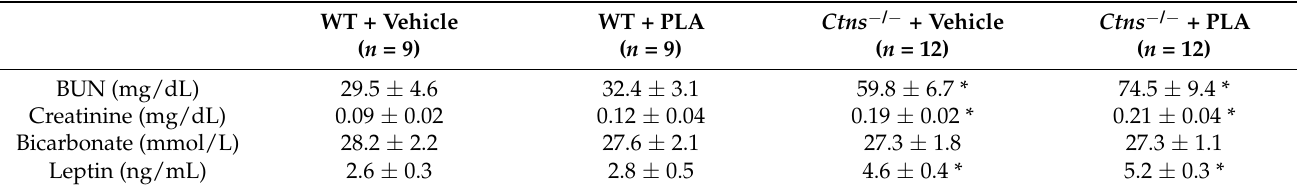
Table 1. Serum and blood chemistry of mice. Twelve-month-old Ctns − / − and WT mice were treated with PLA (7 mg/kg/day, IP) or vehicle (normal saline) for 28 days. Four groups of mice were included: WT + Vehicle, WT + PLA, Ctns − / − + Vehicle and Ctns − / − + PLA. Ctns − / − + Vehicle mice were fed ad libitum whereas WT + Vehicle, WT + PLA and Ctns − / − + PLA mice were pair-fed to that of Ctns − / − + Vehicle mice. Data are expressed as mean ± SEM. Results of Ctns − / − + Vehicle mice were compared to those of WT + Vehicle mice whereas results of Ctns − / − + PLA mice were compared to those of WT + PLA mice. * p <